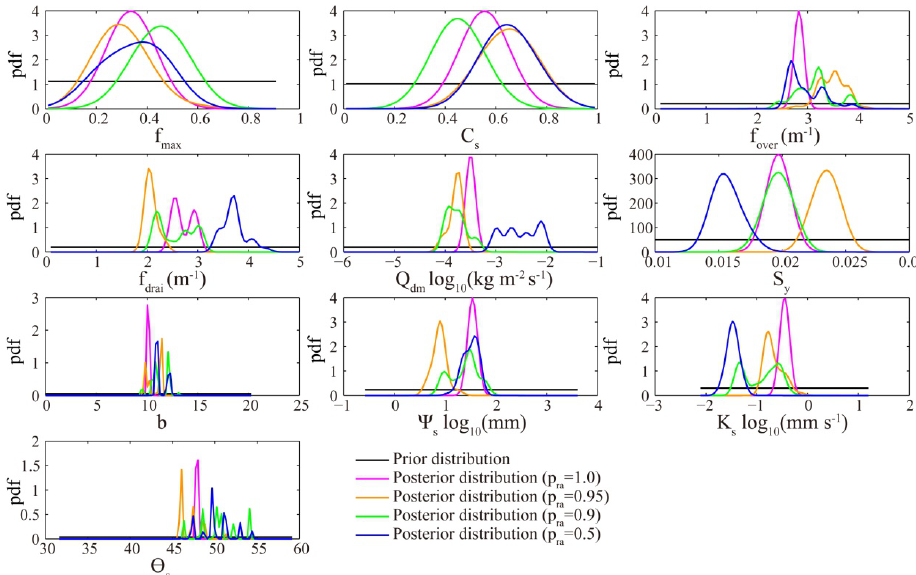
Figure 1.Posterior distribution of the parameters with four different reference acceptance probabilities ( p ra ) using monthly heat flux data at the US-ARM site.